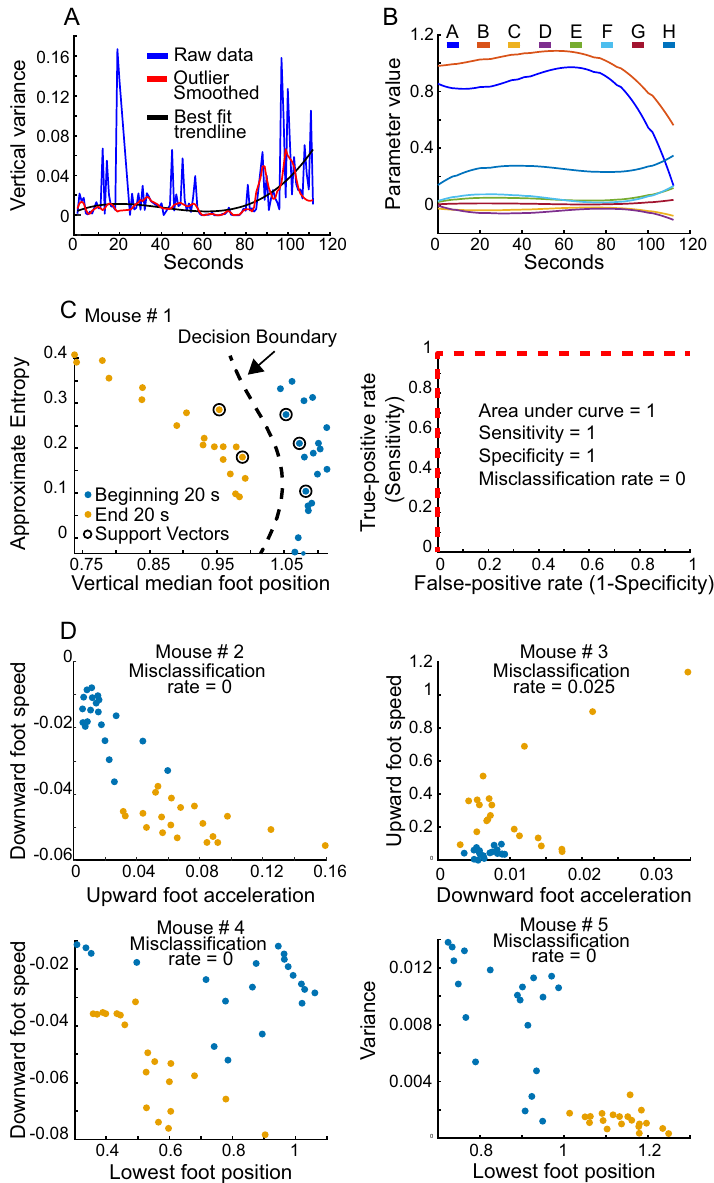
Figure 7. Temporal profile and support vector machine analysis of intra-session features. ( A ) Temporal profile of variance of vertical position of paw calculated for 1 s time intervals (blue line). The red line arises from the treatment of the unmodified data with a function that assigns a value of zero to values that deviate 6 or more standard deviations from the mean. A 3rd degree polynomial least-squares best-fit line (red) illustrates trends across seconds. The last 5 s have been omitted to avoid including values corresponding to a falling mouse. ( B ) Best fit trend lines for several parameters illustrate a change in the last 20 s before the mouse falls off the rotarod. The last 5 s have been omitted to avoid including mouse falls. A = Lowermost paw position, B = median paw position, C = Downward paw speed (negative values indicate downward movement), D = Downward paw acceleration (negative values indicate downward movement), E = Upward paw speed (negative values indicate downward movement), F = Upward paw acceleration (negative values indicate downward movement), G = Variance of the vertical position of the paw, H = Approximate entropy of the vertical position of the paw. ( C ) Support Vector Machine (SVM) classifier. Left panel : Two-dimensional (2D) example scatter plot of vertical paw position and approximate entropy calculated for the first 20 one-second time intervals contrasted with 20 one-second time intervals at the end of the rotarod session. Each dot corresponds a 1-s time interval or bin. The last 5 s have been omitted as above. The data-driven decision boundary distinctly separates the two classes of mice. Right panel : Receiver operating characteristic (ROC) curve for classifying the first and last 20-s time-bin data in separate clusters for the mouse depicted in the left panel. The classifier analysis was conducted in 6-dimensional space on vertical and horizontal paw speed, acceleration, and variance of paw position calculated for 21-s time bins. (D) Scatter plots for different mice illustrating separation of features corresponding to the first and last 20 s of a rotarod session. The misclassification rate (MR) calculated from an SVM classifier is indicated for each